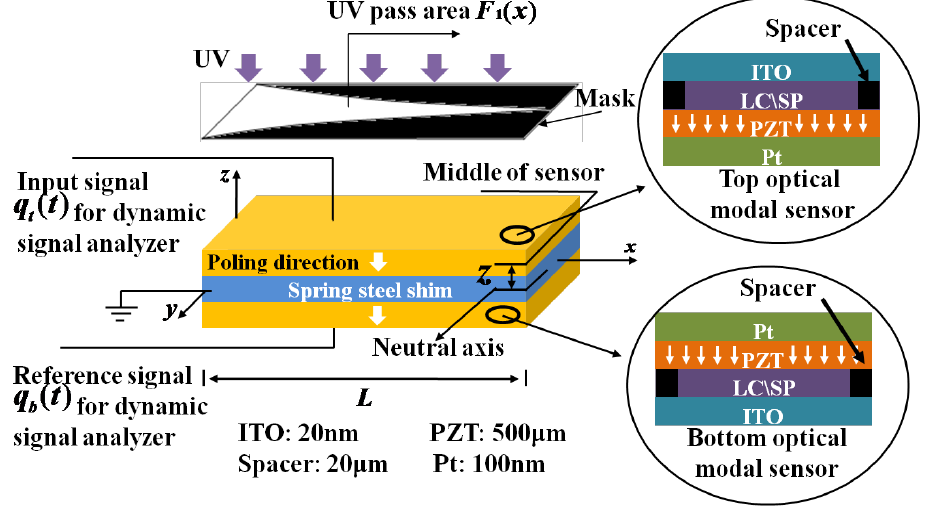
Figure 5. Schematic of the optical modal sensor system employed for the mode 1 sensor. The thickness of the ITO, spacer, PZT, and Pt were 200 nm, 20 μm, 500 μm, and 100 nm,